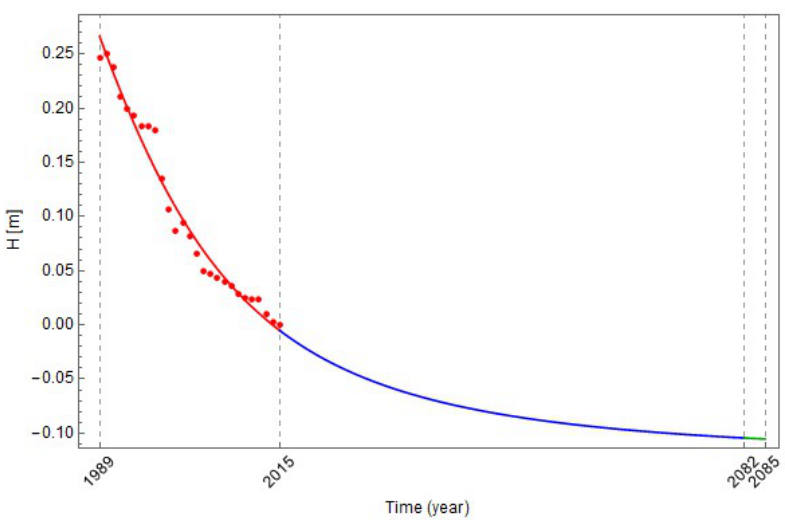
Figure 11. Graphical presentation of results from analysis of vertical displacement of point 367a/4.